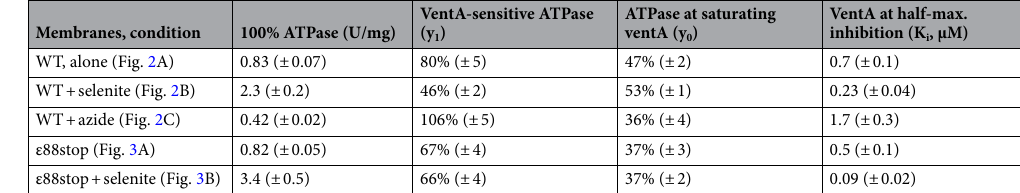
Table 1. Best-fit parameters for early inhibition of E. coli membrane ATPase by venturicidin A. Values for the best-fit parameters are listed for curves of Figs. 2 and 3 for nonlinear regression of the hyperbolic dependence [y = y 0 + y 1 /(1 + x/K i )] of relative ATPase early rates (y) on the concentration of ventA added (x). For each experiment, the 100% ATPase value is the average specific activity of all assays measured just before the addition of ventA.